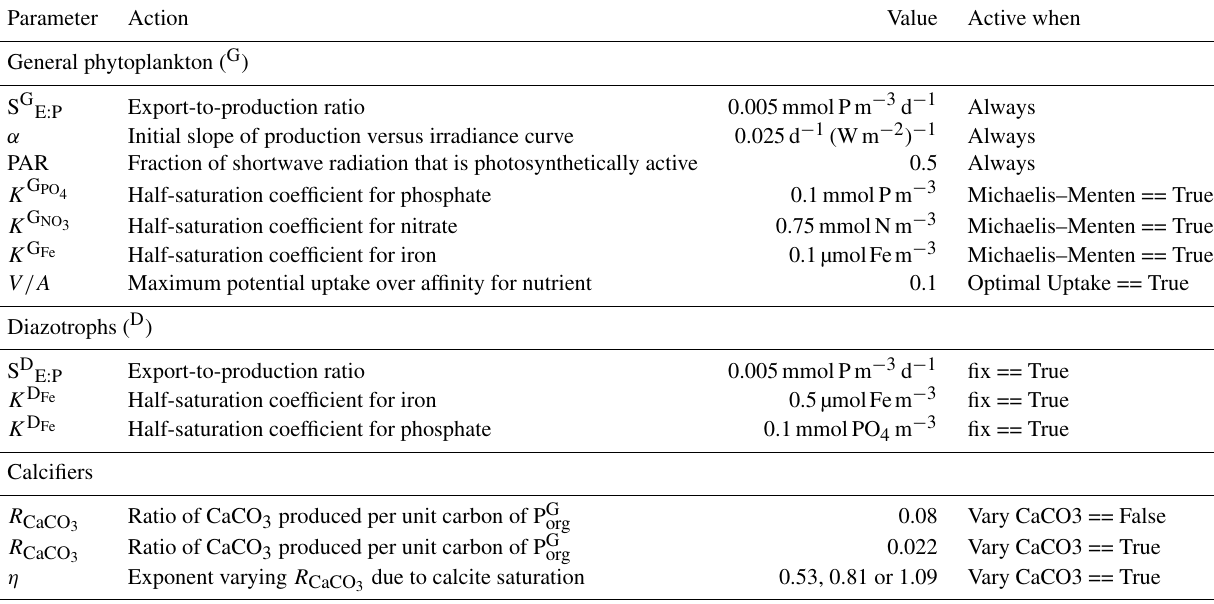
Table B1. Parameter values controlling export production in the ecosystem component of the CSIRO Mk3L-COAL ocean model. Default settings: Michaelis–Menten == False , Optimal Uptake == True , fix == True and Vary CaCO3 == False